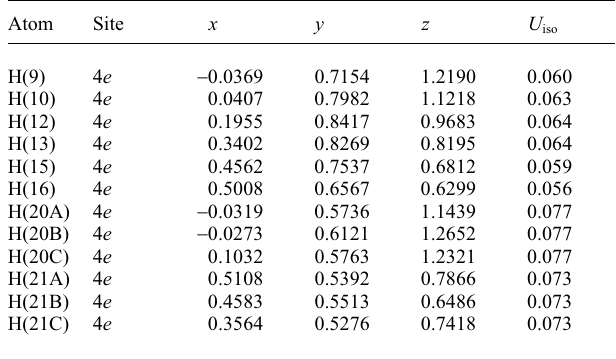
Table 2. Atomic coordinates and displacement parameters (in Å 2 )